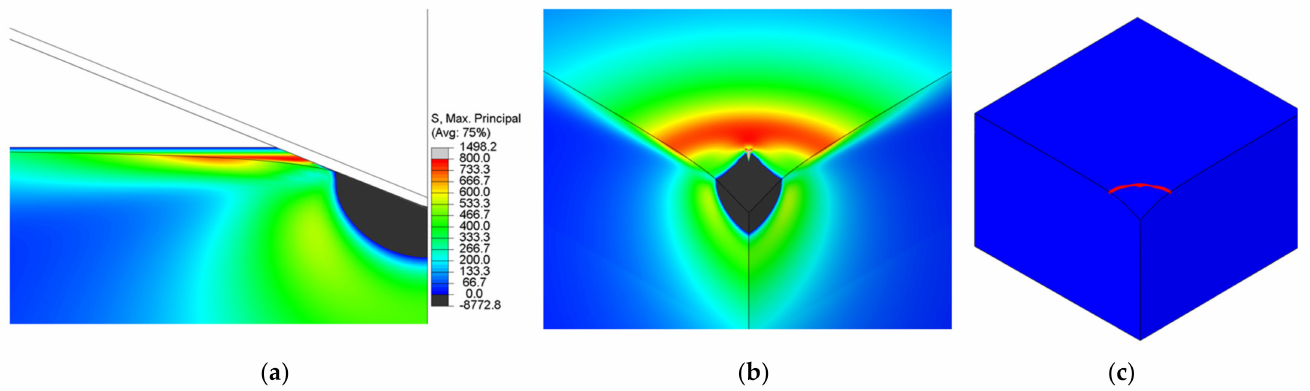
Figure 7. Positive maximum principal stress (in MPa) on specimen surface as a cause of cone-crack initiation, ( a ) stress distribution (in MPa) in front plane, ( b ) stress distribution in isometric view (without the indenter), showing ring-like distribution outside the contact region, and ( c ) isometric view (without the indenter) of the initiation